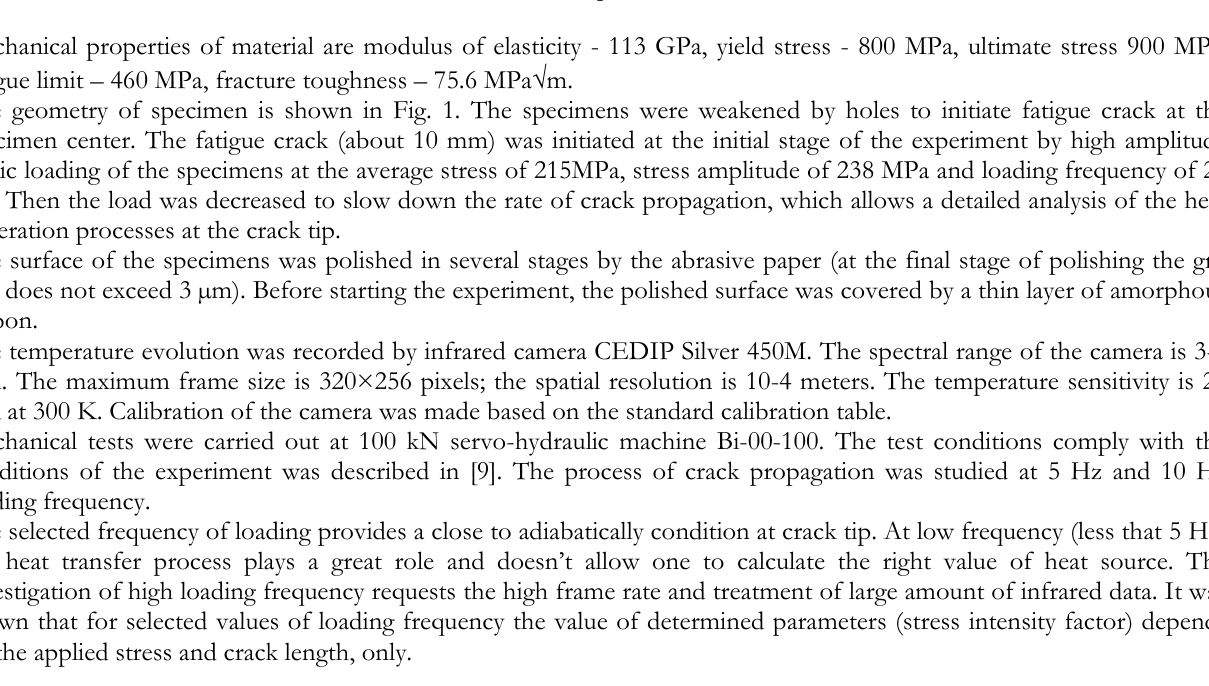
Table 1: Chemical composition of Ti-6Al-4V.